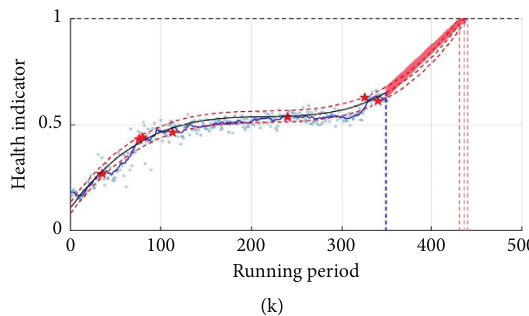
Figure 8: The RUL prediction results of all the test bearings. (a) Bearing 1_3 performance degradation trend prediction. (b) Bearing 1_4 performance degradation trend prediction. (c) Bearing 1_5 performance degradation trend prediction. (d) Bearing 1_6 per- formance degradation trend prediction. (e) Bearing 1_7 performance degradation trend prediction. (f) Bearing 2_3 performance degradation trend prediction. (g) Bearing 2_4 performance degradation trend prediction. (h) Bearing 2_5 performance degradation trend prediction. (i) Bearing 2_6 performance degradation trend prediction. (j) Bearing 2_7 performance degradation trend pre-